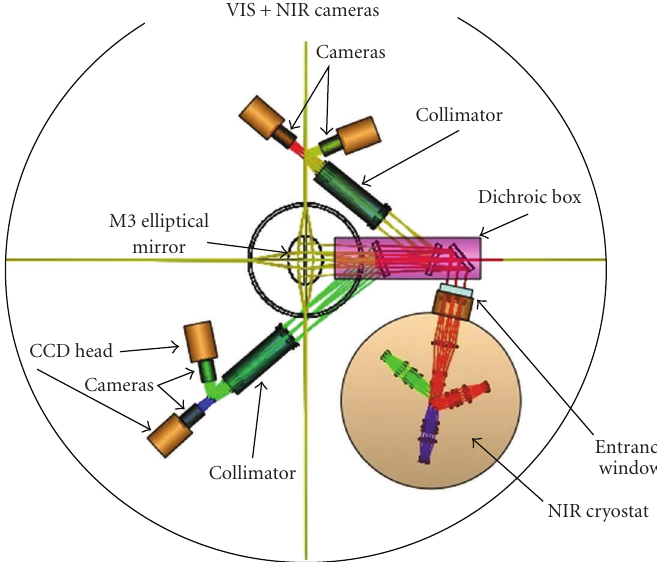
Figure 5: The optical scheme of the Pathos focal plane, with the VIS and NIR cameras.